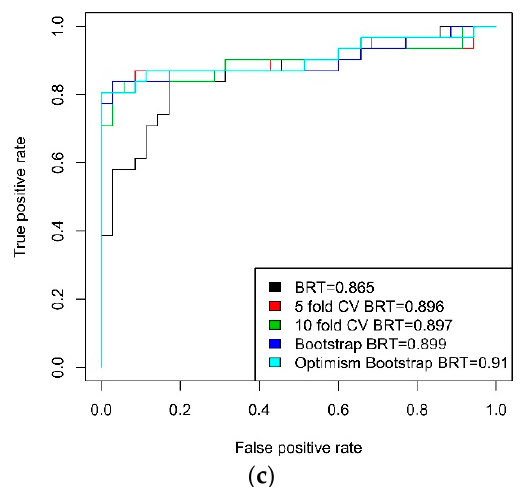
Figure 6. ROC curve analysis of ( a ) MARS, ( b ) SVM and ( c ) BRT for forest fire susceptibility models using the test validation dataset.